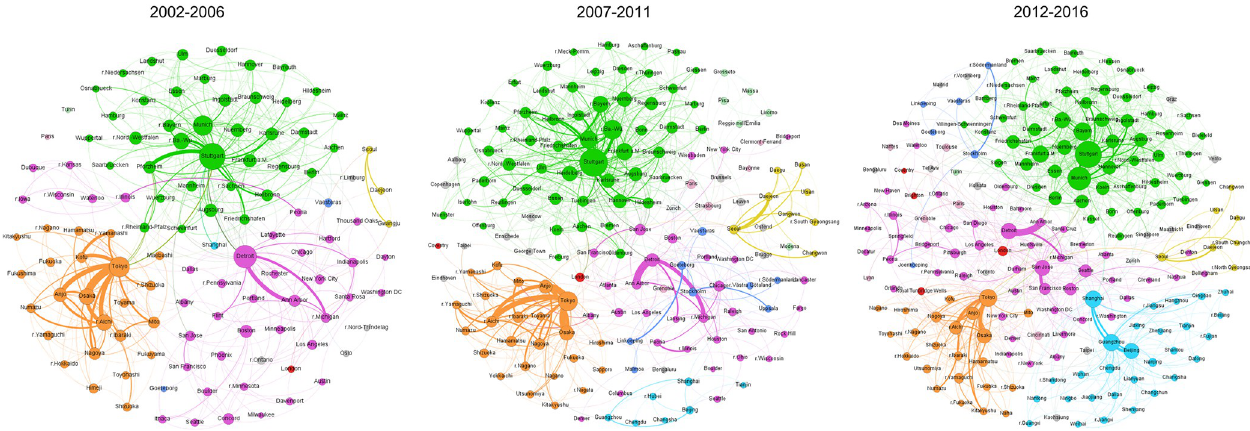
Fig 2. Global area R&D collaboration network in